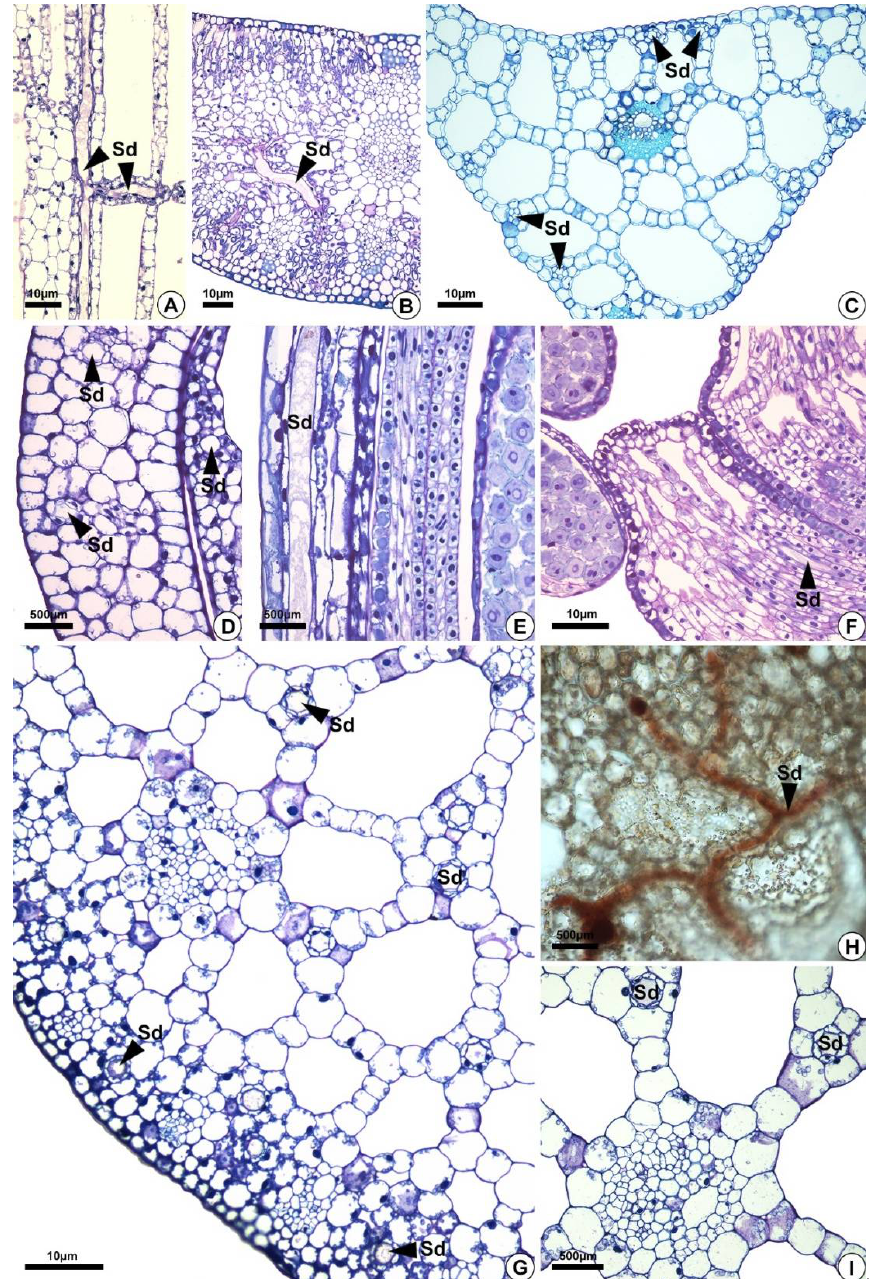
Figure 4. Distribution of secretory ducts in the petiole, leaf blade, and perianth of Sagittaria rhombifolia and Helanthium tenellum . ( A , B , D – I ) Sagittaria rhombifolia . ( C ) Helanthium tenellum. All preparations were stained with toluidine blue, except for ( H ) which was stained with oil red reagent that reacted positively in orange for lipids. ( A ) Longitudinal section of the petiole. Note the secretory ducts distributed vertically and longitudinally in the aerenchyma (arrowheads). ( B , C ) Secretory ducts in the leaf blade and the midrib of a cross-section. ( D – F ) Longitudinal section of the floral organs. ( D , E ) Secretory ducts in the perianth (arrowheads). ( F ) Secretory ducts in the filament (arrowheads). ( G – I ) Cross-sections. ( G ) Cross-section of a petiole. Note the secretory ducts in the cortex and the aerenchyma (arrowheads). ( H ) Secretory ducts in the diaphragm showing lipids in orange. ( I ) Secretory ducts in the aerenchyma around the vascular bundle. Sd = secretory ducts.